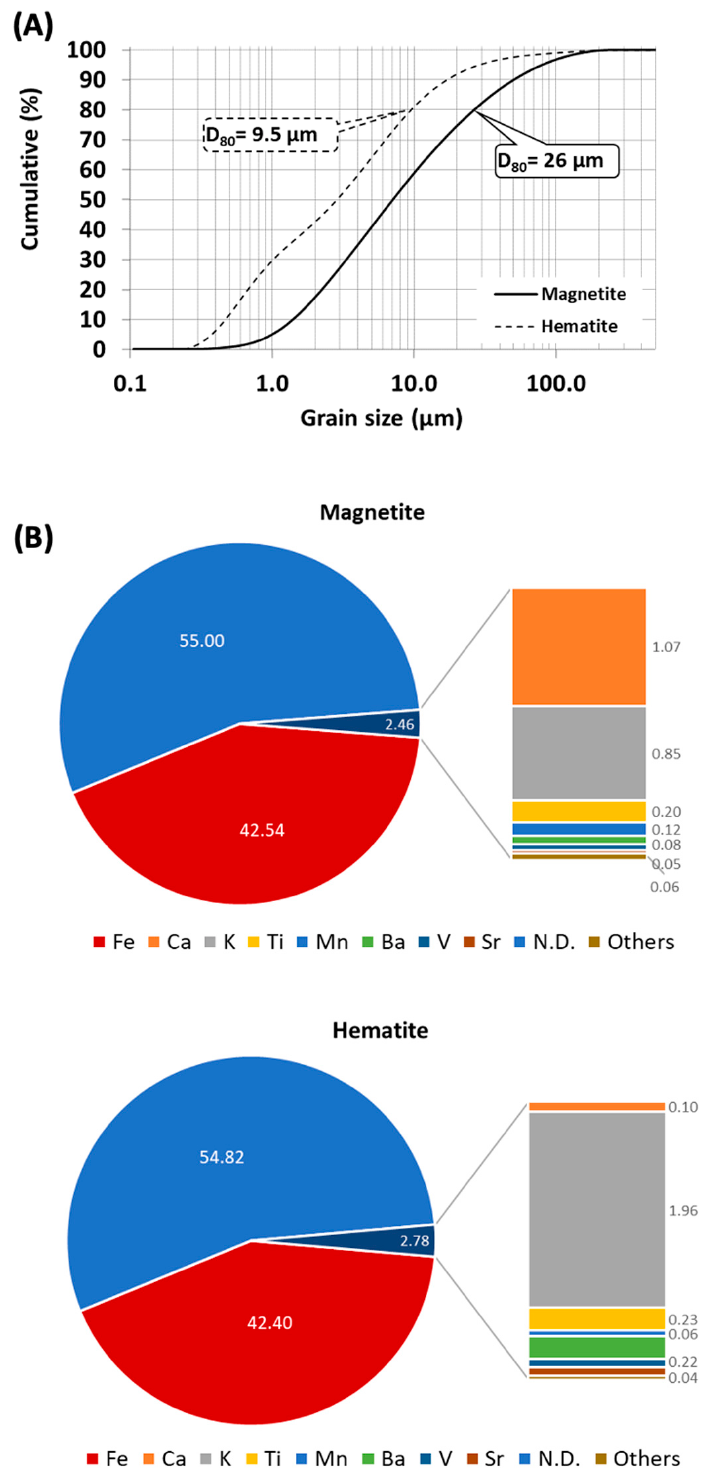
Figure 3. Characterization of the natural magnetite and hematite in terms of ( A ) particle size and ( B ) elemental composition of used minerals.